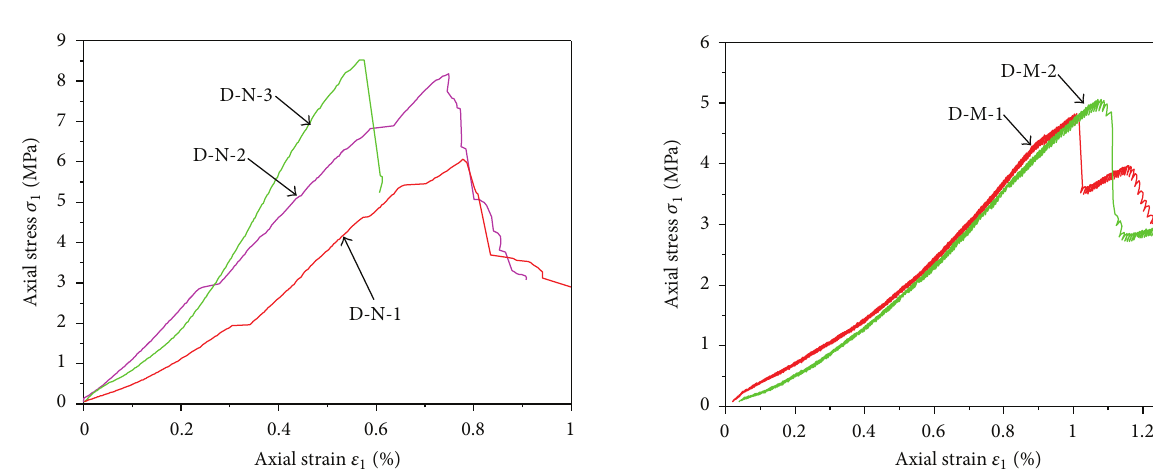
Figure 3: Stress-strain relations of mudstone samples under uniax- ial compression with different moisture contents.